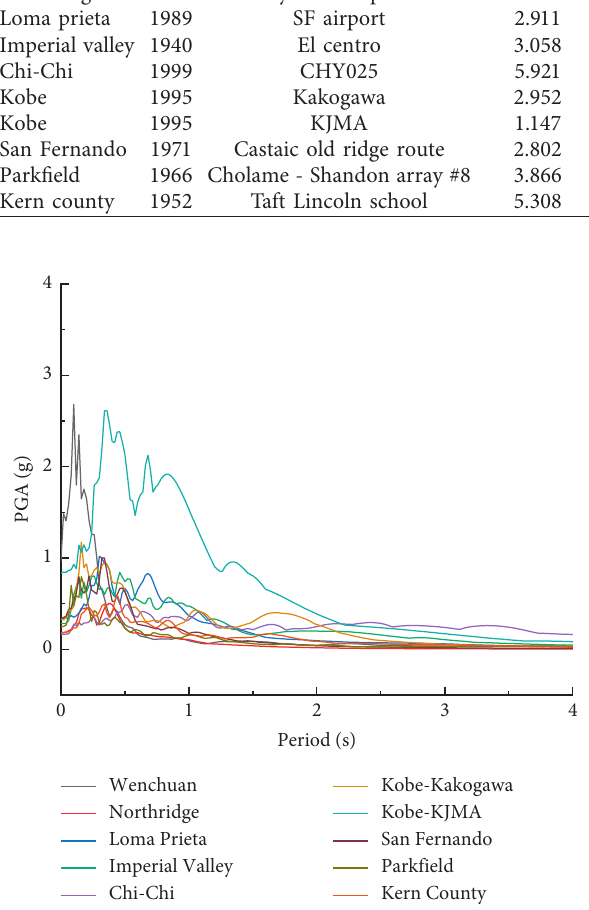
Figure 14: Acceleration response spectra of selected records.